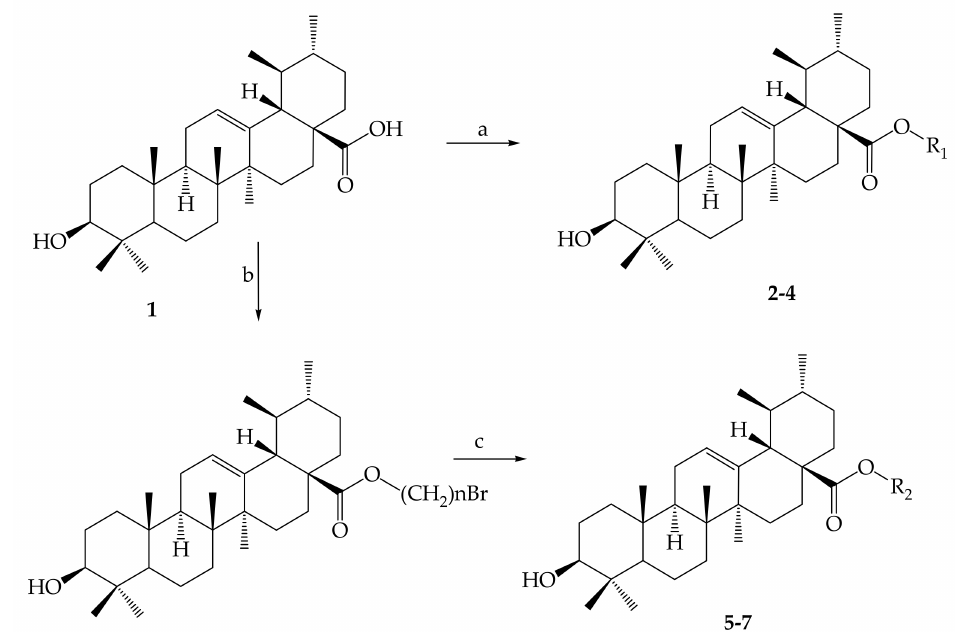
Figure 2. Preparation of UA ester derivatives. Reagents and conditions: (a) CH 3 (CH 2 ) n